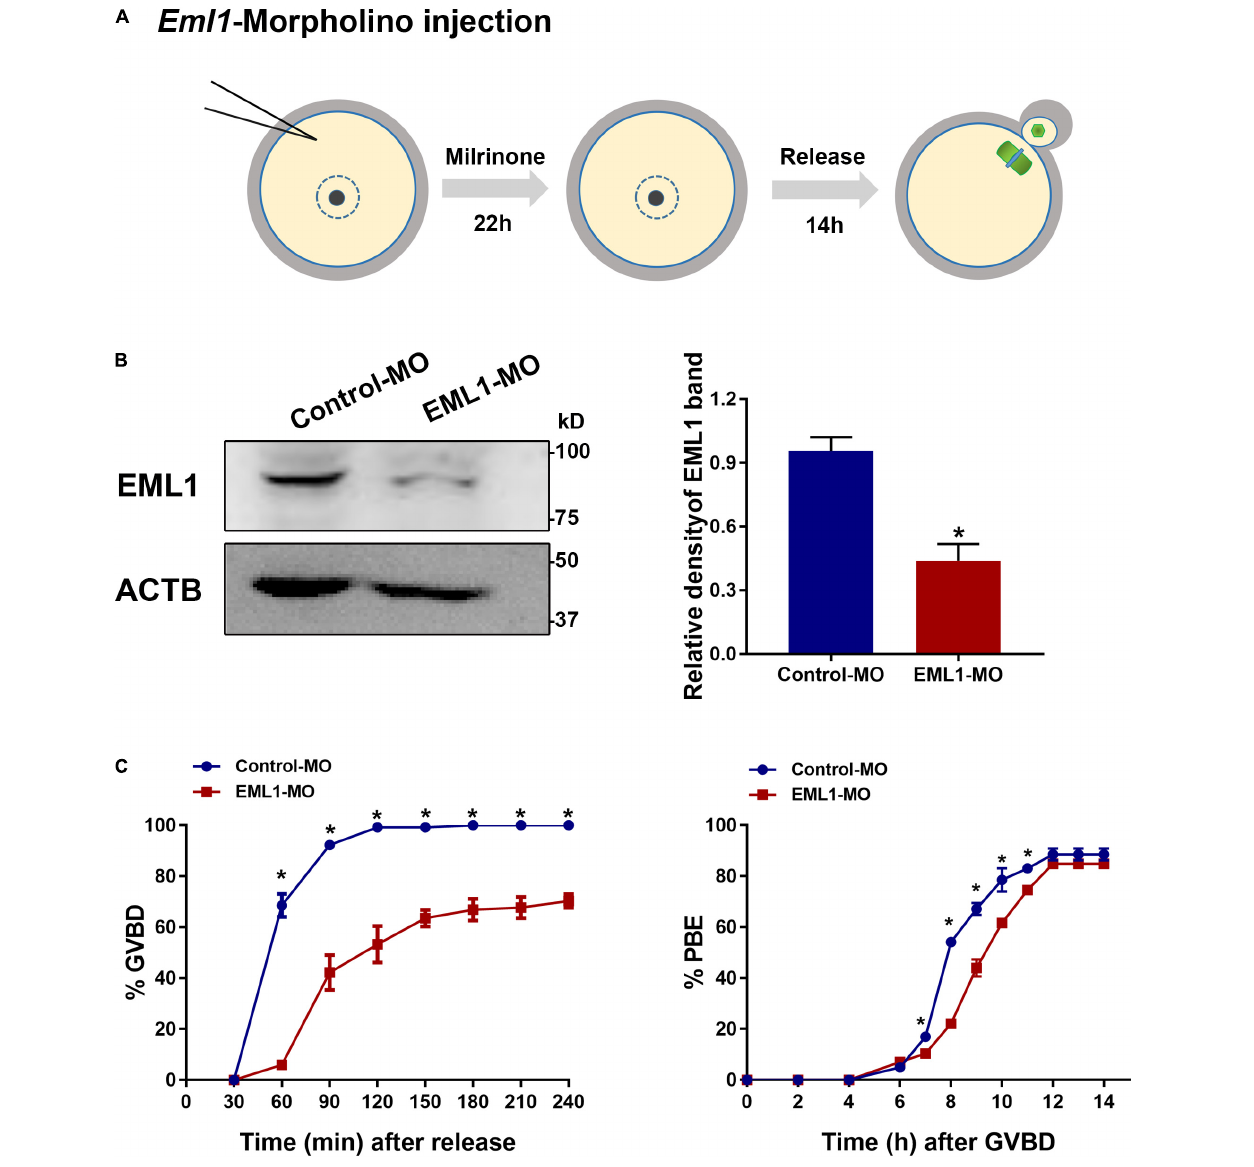
FIGURE 3 | Knockdown of EML1 expression in oocytes causes the delay of meiotic progression. (A) Schematic illustration of the experimental design for examining the effect of EML1 knockdown on oocyte meiotic maturation. (B) WB analysis of the efficiency of knocking down EML1 in oocytes by EML1-morpholino oligos (MO). Lysate from 200 oocytes was loaded in each lane. ACTB serves as internal control. Representative gel image is shown in the left panel, whereas quantification of the WB result is shown in the right panel. * P < 0.05, compared with the Control-MO. (C) Effect of knockdown of EML1 in oocytes on the kinetics of GVB (left graph) and PBE (right graph). * P < 0.05, compared with the EML1-MO